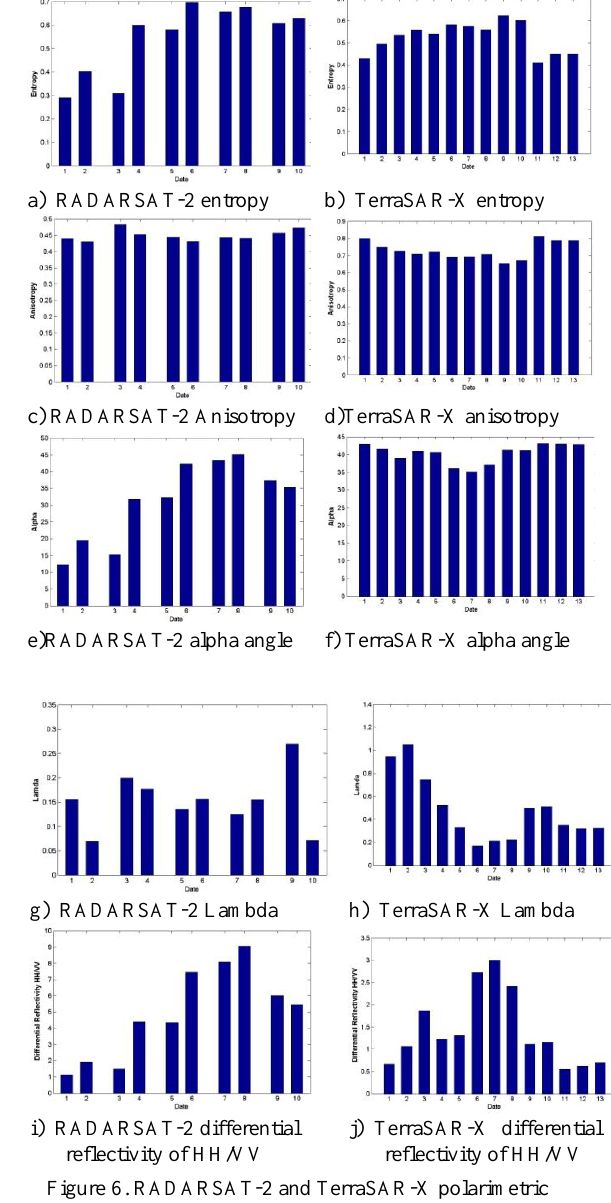
Figure 6. RADARSAT-2 and TerraSAR-X polarimetric parameter comparison for wheat crop type. Date in X-axis is from April 16 to July 31 for RADARSAT-2, and May 8 to September 17 for TerraSAR-X as Shown in Table 1 Similar as in canola crop type case, additional RADARSAT-2 polarimetric parameters are also given in Figure